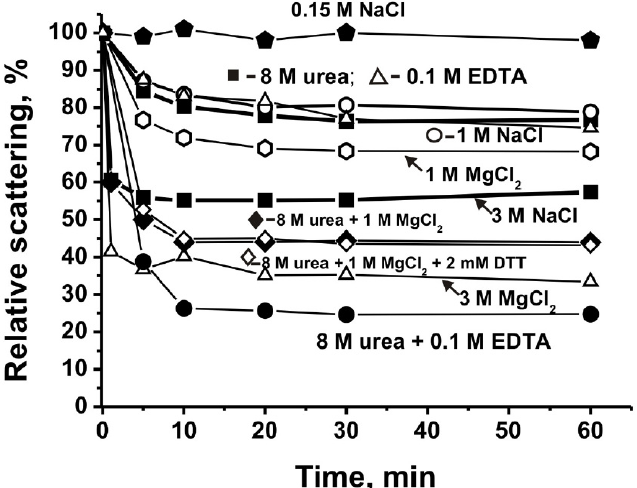
Figure 2. Typical examples of the time changes in the light scattering (LS) of the cucumber complex (0.005 mg/mL) in the presence of 20 mM Tris-HCl buffer (pH 7.5) containing urea, NaCl, MgCl 2 , DTT, and EDTA in various concentrations and different combinations, detailed in the Figure.